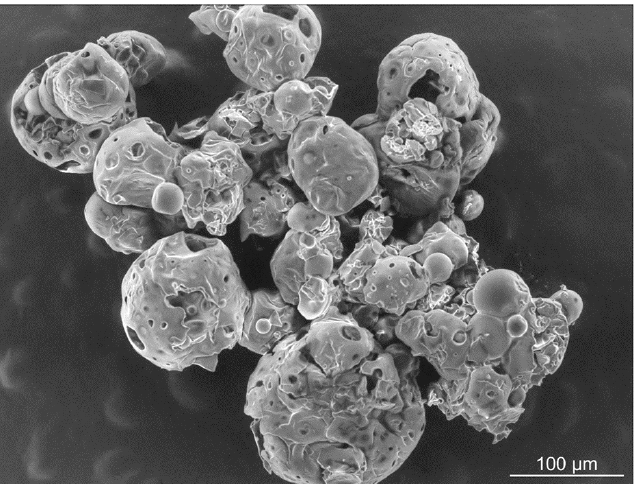
Figure 1. SEM micrograph of colophony microcapsules added to modify the epoxy coating.